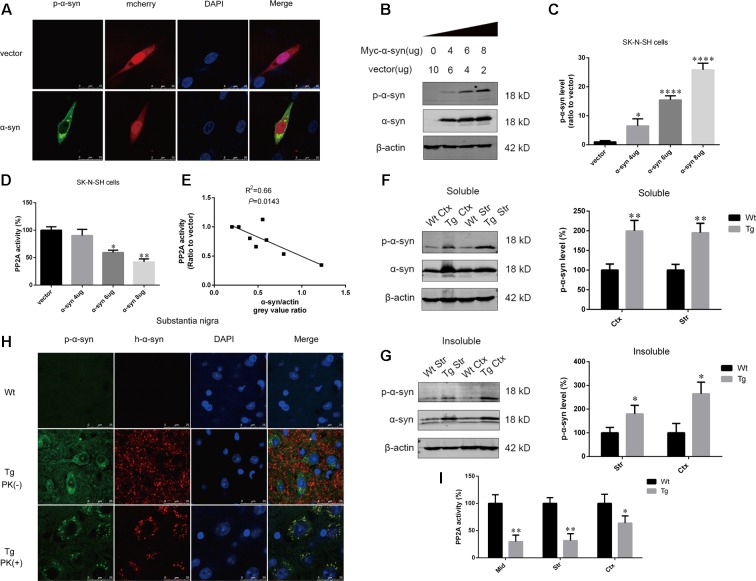
α-syn overexpression increased α-syn phosphorylation at Ser129. (A) Representative immunofluorescence images showing cells transfected with pmCherry-N1 or pmCherry-N1-α-syn stained with the anti-phosphorylated α-syn antibody. Scale bar = 25 μm. (B,C) Immunoblot results and quantifications of phosphorylated α-syn at Ser129 (p-α-syn) and α-syn levels in SK-N-SH cells transfected with increasing amounts of pCMV-Myc-α-syn (4, 6, and 8 μg). pCMV-Myc plasmid was added to keep the total amount of DNA equal in each transfection. β-actin was used as a loading control. The ratio of p-α-syn to β-actin in vector group was considered as 100%. (D) Measurement of PP2A activity for the aforementioned groups. (E) Correlation between α-syn level and PP2A activity. (F,G) Immunoblot results and quantifications of p-α-syn and total α-syn level in the RIPA soluble and insoluble fraction of cortex as well as striatum of α-syn Wt and Tg mice. β-actin was used as a loading control. The ratio of p-α-syn to β-actin in Wt group was considered as 100%. (H) Representative immunofluorescence images from Wt and Tg mice slices of substantia nigra treated with or without PK. (I) Measurement of PP2A activity in examined brain regions of Wt and Tg mice. Data are expressed as mean ± SD. Kolmogorov–Smirnov (KS) test; P > 0.05. In C,D: Brown–Forsythe test; P > 0.05; one-way analysis of variance; ∗P < 0.05, ∗∗P < 0.01, ∗∗∗∗P < 0.0001 vs. vector (n = 3); In F,G,I: F-test; P > 0.05; unpaired Student’s t-test; ∗P < 0.05, ∗∗P < 0.01 vs. Wt mice (n = 3). The associations between α-syn level and PP2A activity were determined with Pearson correlation analysis.